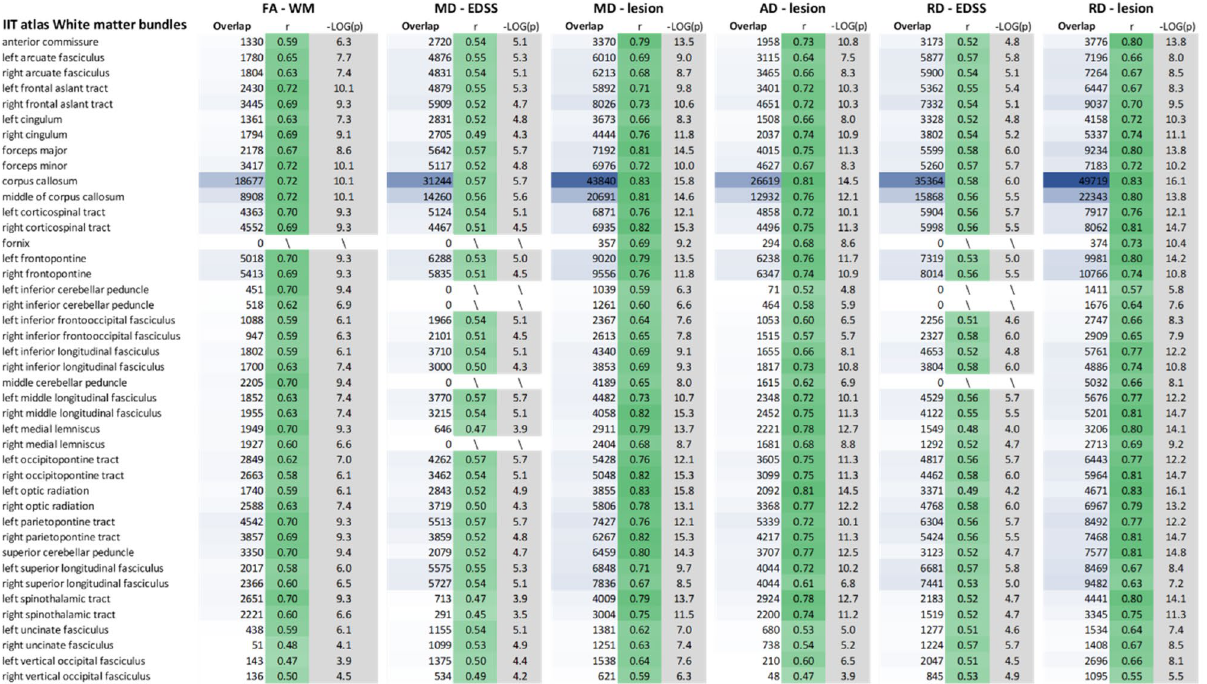
Table 4. Strongest observed correlation in the PwMS group between diffusion tensor parameters and volumetric parameters and EDSS for each bundle of the IIT white matter bundle atlas. Bundles without any significant correlations are indicated with a backslash and a red (negative) and green (positive) colour palette is used to facilitate visual interpretation of the R values. The r column represents the strength of the correlation and − LOG( p ) shows the significance on the inverse logarithmic scale (cut-off p value of 0.001 is − LOG10( p ) = 3). The volume of the shared region between the considered cluster and the tracks is shown in mm 3 . MD mean diffusivity, RD radial diffusivity, BVMT brief visuospatial memory test-revised,